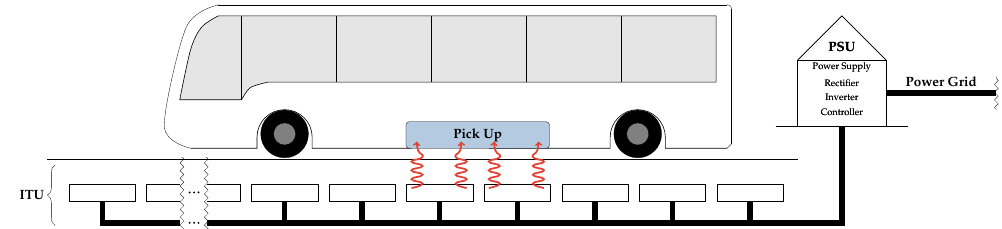
Figure 1. Components of the dynamic inductive charging system (Reprinted with permission from Helber et al.